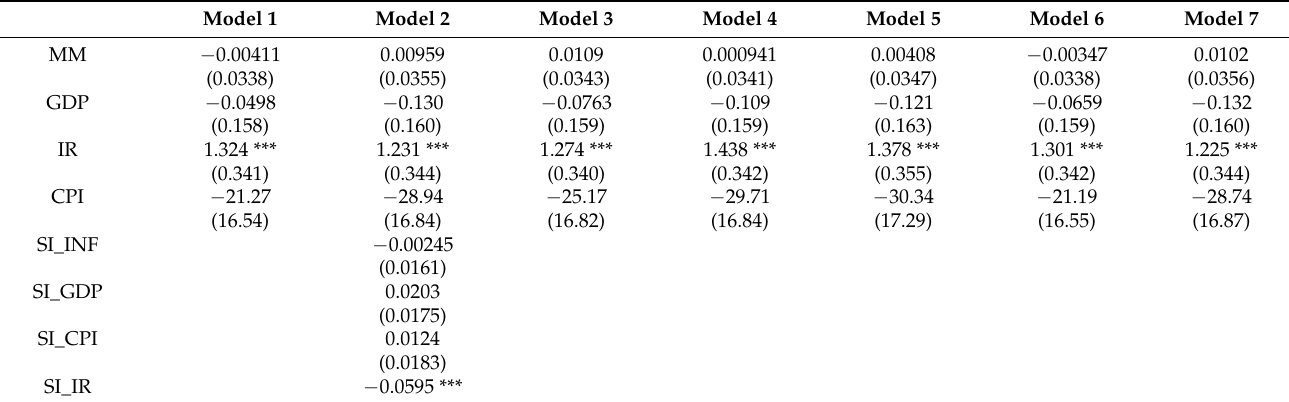
Table A15. Panel Regression Table Fixed-Effects OM Models